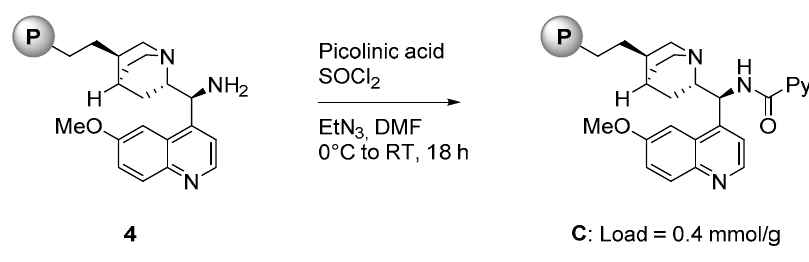
Figure 2. Synthesis of polystyrene-supported catalyst C .